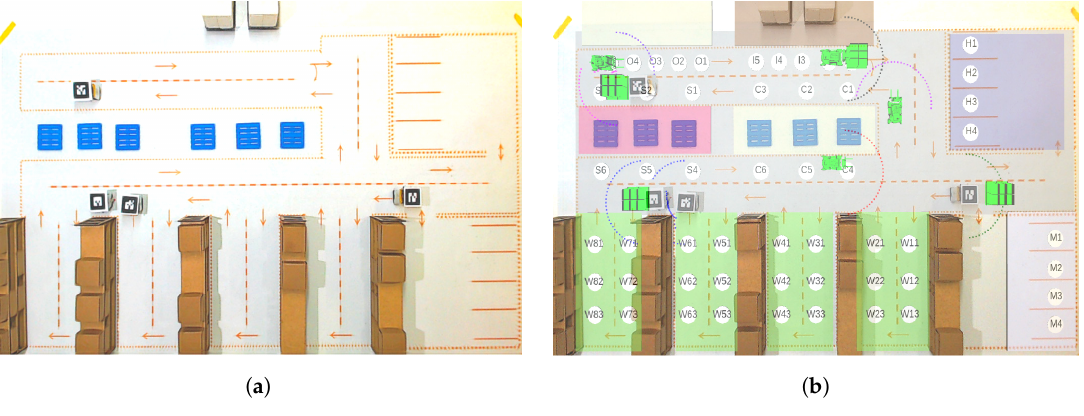
Figure 11. Improvements of AR in the ARENA: ( a ) top view of ARENA only with real elements; and ( b ) top view of ARENA with